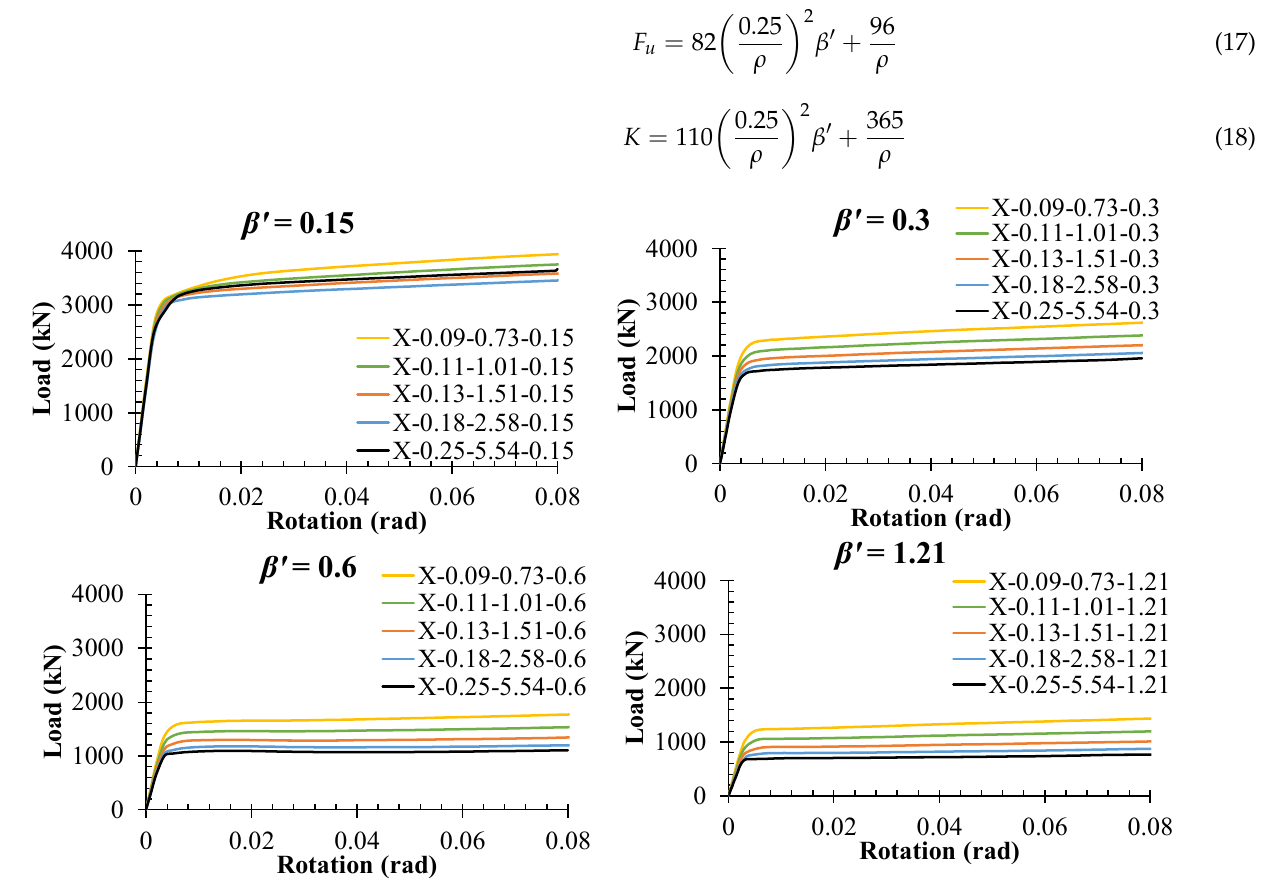
Figure 6. Comparing load-rotation graphs of dampers based on β ’.